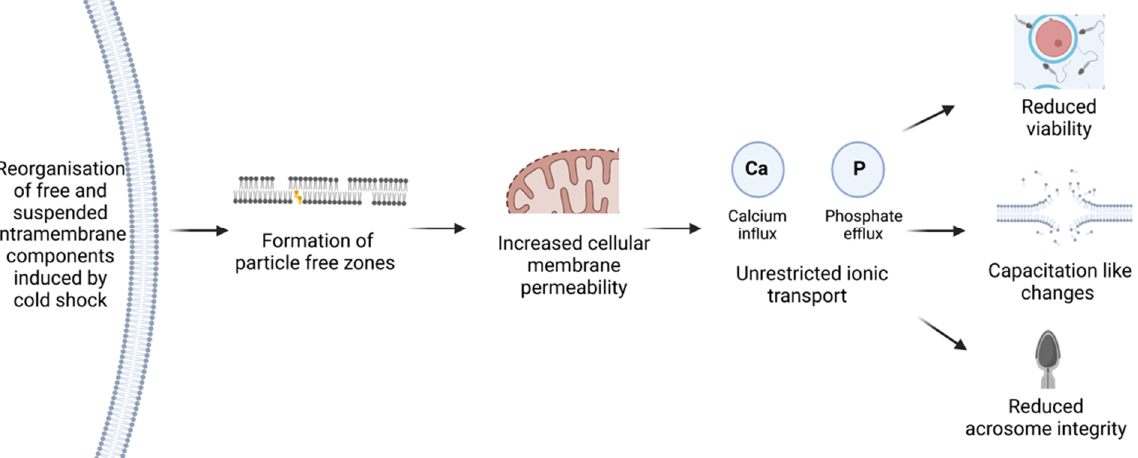
Figure 1. Summary of cascading membrane damage induced by cold shock in ram spermatozoa stored at temperatures below 18 °C. Adapted from [4,11]. Created on Biorender.com.